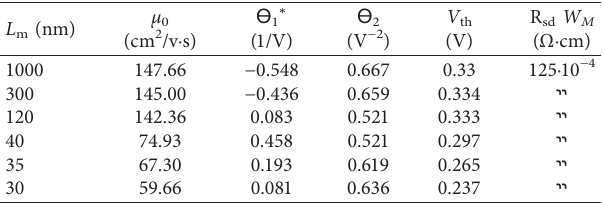
Figure 1: (a) Typical structure of 14nm NMOS FDSOI device featuring a gate stack TiN on bilayer oxide HfSiON +SiON with Si channel and P-Well substrate. (b) Two-dimensional bilayer FDSOI structure. Table 1: Extracted main static MOSFET parameters (Uncertainty estimation: ±